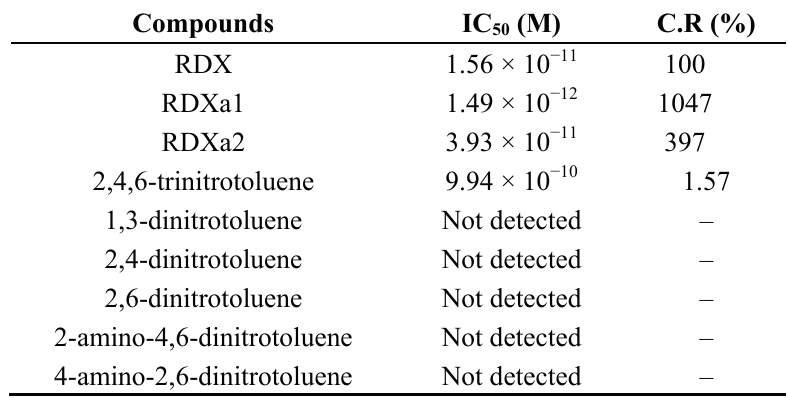
Table 1. Cross-reactivity of rat anti-RDX monoclonal antibody